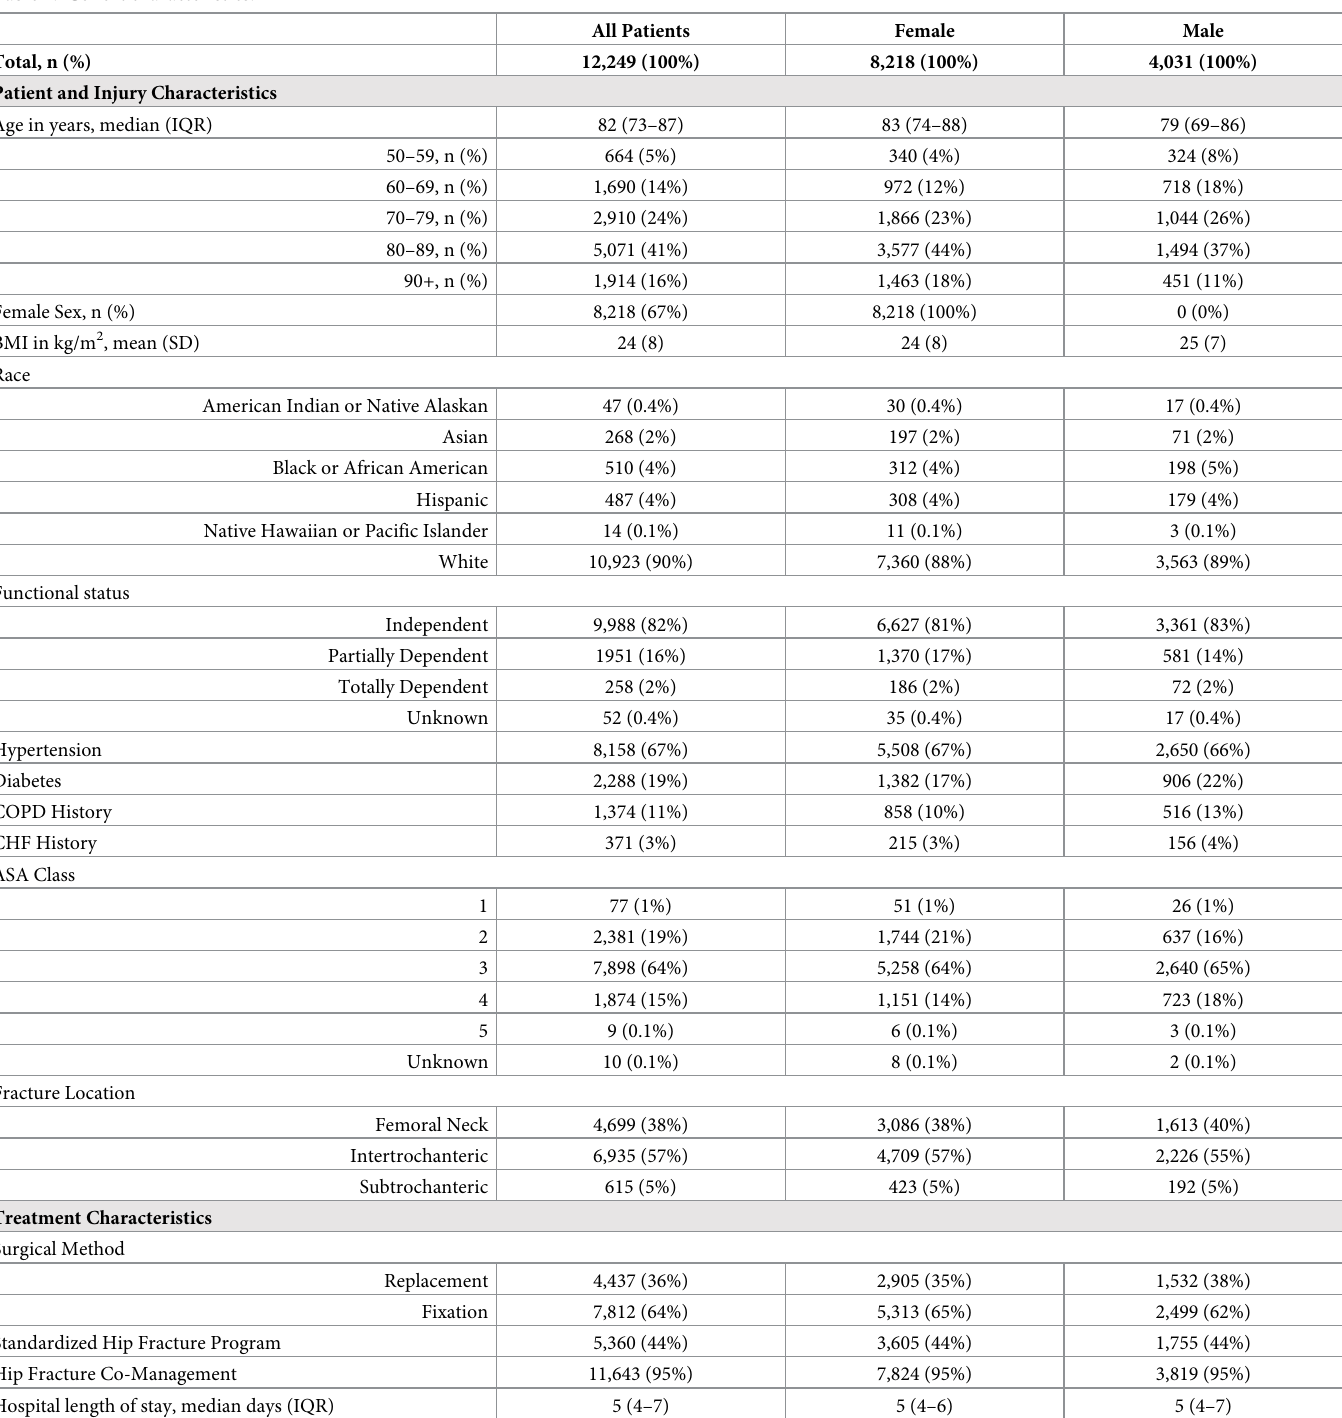
Table 2. Cohort characteristics.